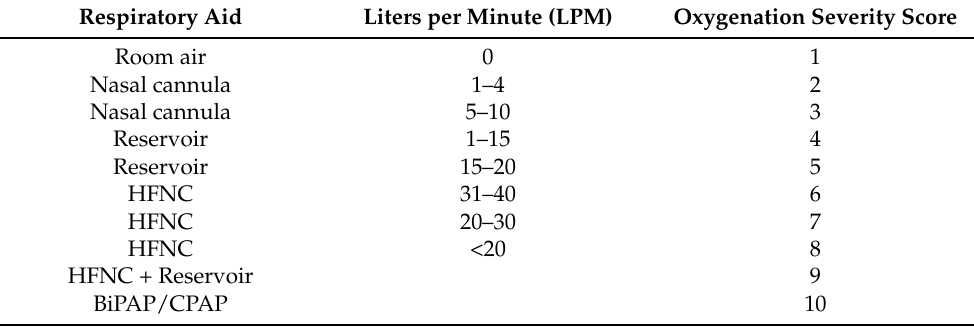
Table 1. Oxygenation Severity